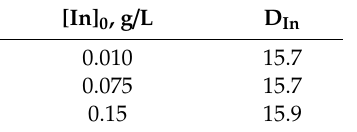
Table 2. Experimental distribution data at various metal concentrations.